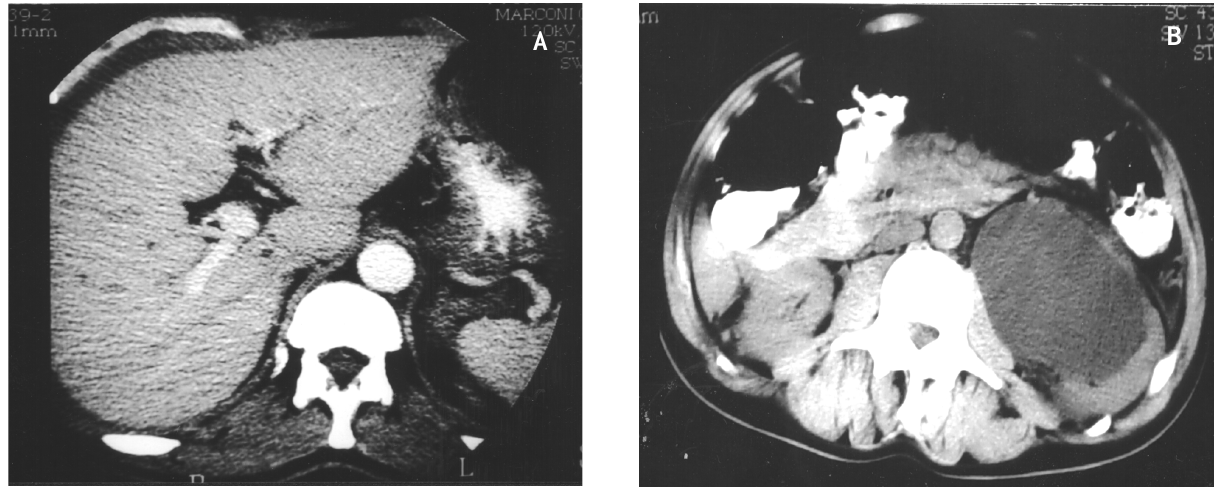
Figure 1 – Computerized tomography of abdomen. A) - Tumor in left adrenal measuring approximately 5 x 4 cm. B) - Extensive retroperitoneal hematoma on the left.